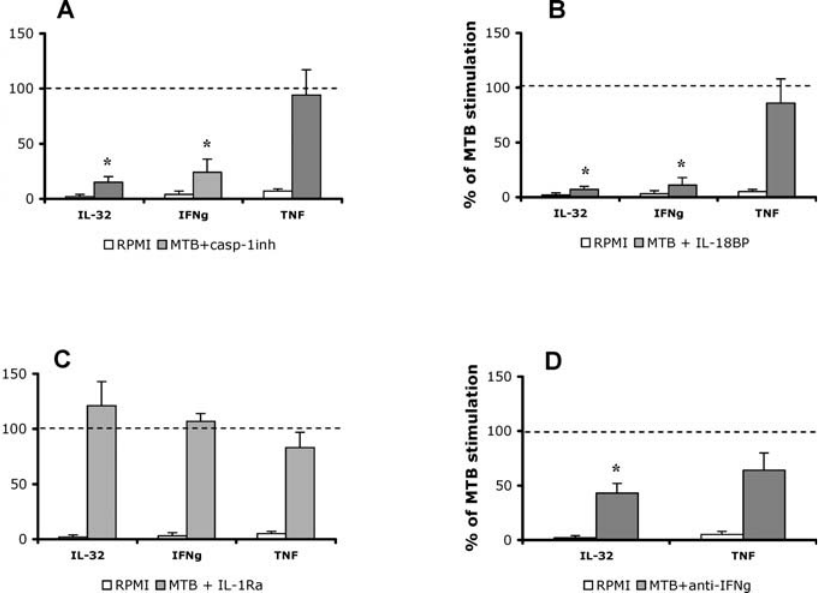
Figure 6. M. tuberculosis Stimulates IL-32 through a Caspase-1/IL-18/IFN c -Dependent Mechanism PBMCs were stimulated with RPMI, M. tuberculosis (MTB), or a combination of M. tuberculosis and cytokine inhibitors: 20 l M of a caspase-1 inhibitor (casp-1inh) (A), 10 l g/ml IL-18BP (B), IL-1Ra (C), or 10 l g/ml of a monoclonal mouse anti-human IFN c antibody (D). As a control for the anti-IFN c antibody, a similar concentration of a purified mouse IgG1 antibody was used in the control stimulation. After 24 h of incubation, IL-32, IFN c , and TNF concentrations were measured by ECL. The dashed line represents the 100% stimulation induced by M. tuberculosis alone. The open bars represent the unstimulated cells, and the solid bars represent the cells stimulated with M. tuberculosis in the presence of the cytokine inhibitors, expressed as percent of M. tuberculosis production. Data are presented as means 6 SEM ( n ¼ 8); *, p , 0.05. DOI: